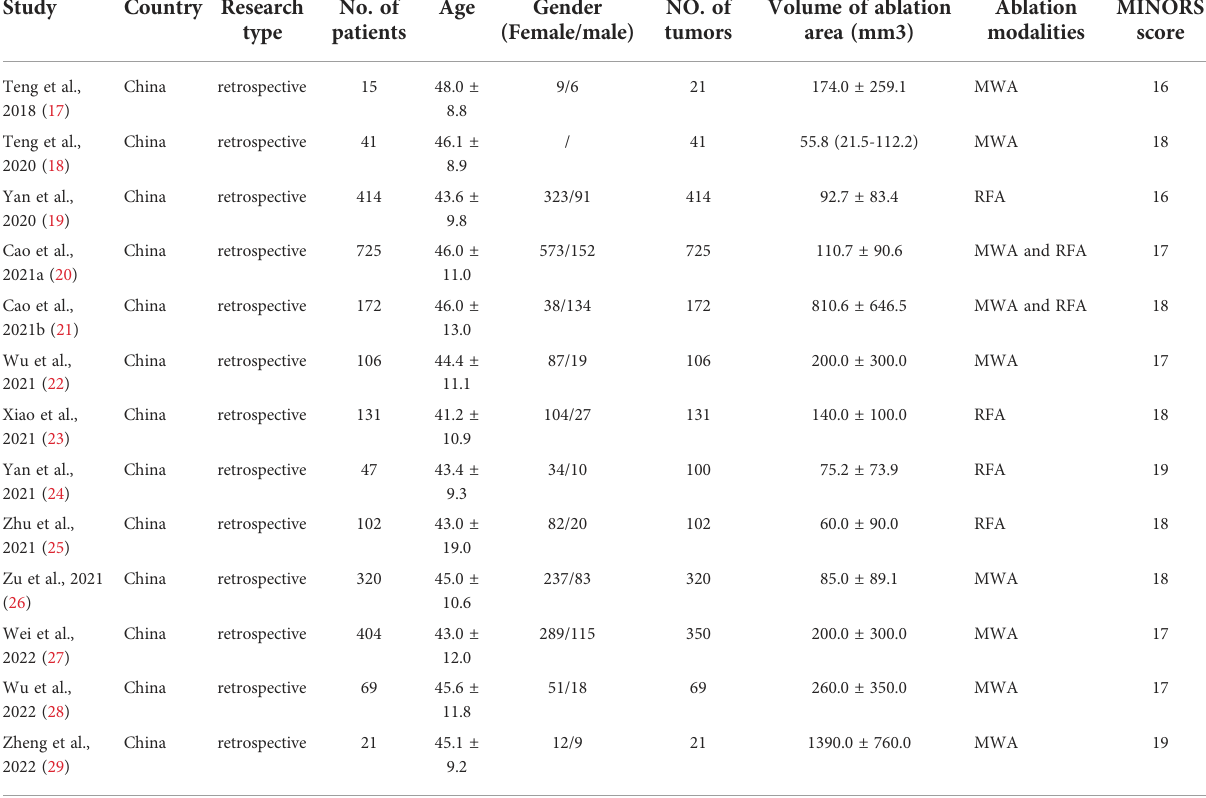
TABLE 1 Baseline characteristics and quality assessment of the included